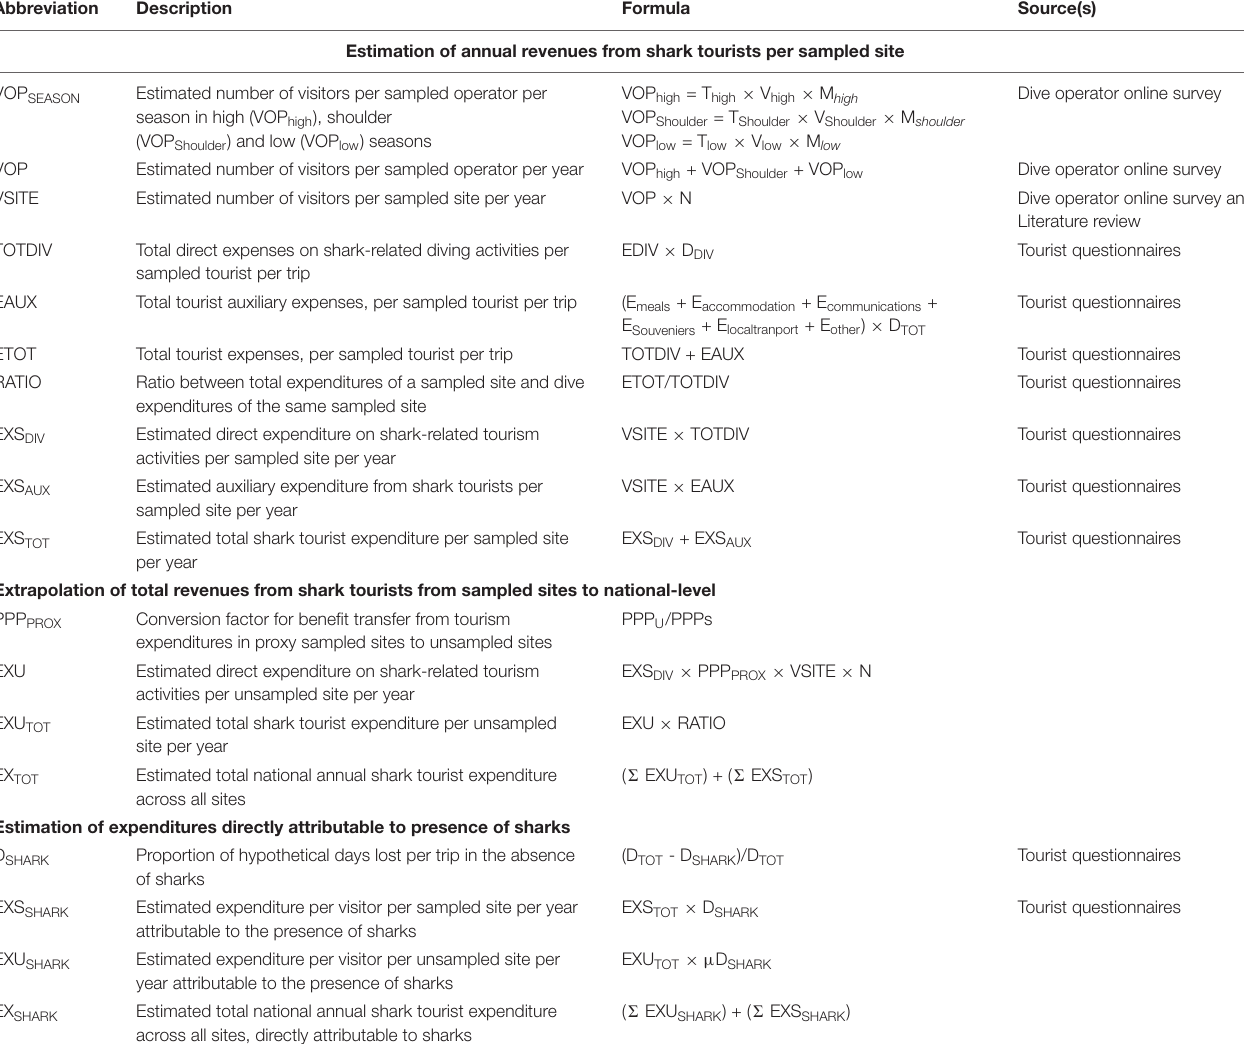
TABLE 3 | Formula used to calculate the economic value of revenues from shark and ray tourism in